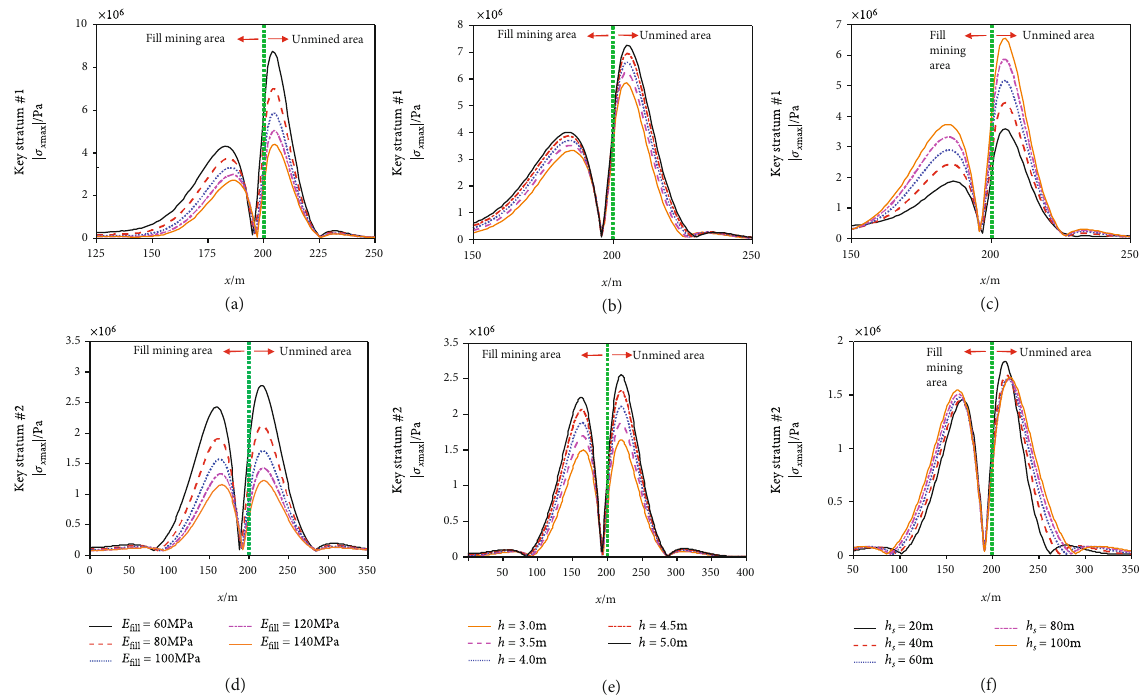
Figure 10: The horizontal stress distribution of key strata with the distance to the middle of the stope under various (a, d) elastic modulus of back fi ll, (b, e) mining height, and (c, f) thickness of soft